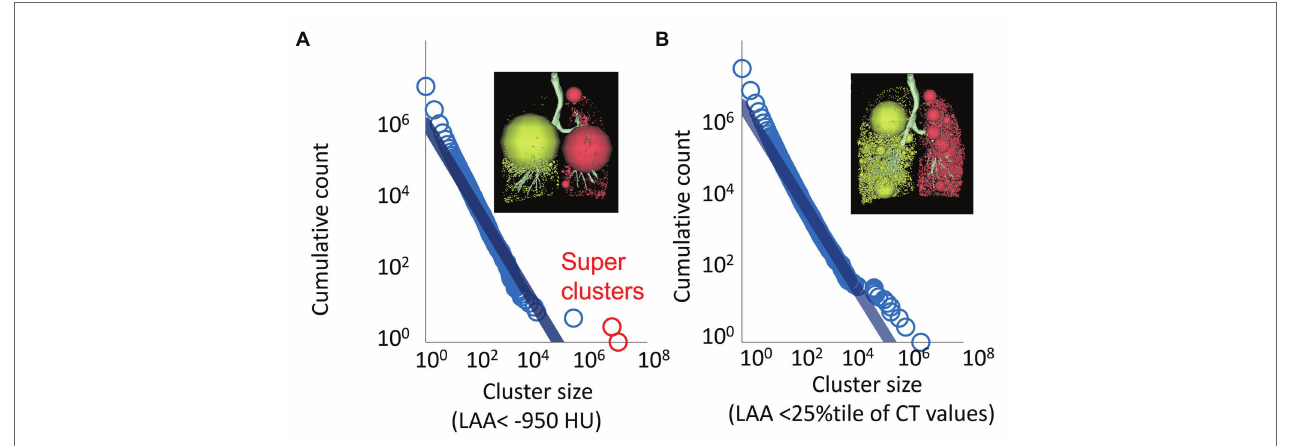
FIGURE 4 | Superclusters not following the single power-law distribution and an alternative power-law analysis using relatively lower attenuation clusters on CT. (A) LACs were defined as 3D connecting voxels < − 950 HU on CT. A log-log plot for cluster size and cumulative count of LACs larger than a given size showed that two very large clusters (red circles, superclusters) did not follow the power-law distribution. (B) Relatively lower attenuation clusters were defined using a threshold of the 25th percentile of the distribution of CT numbers instead of a fixed threshold to define emphysema, such as − 950